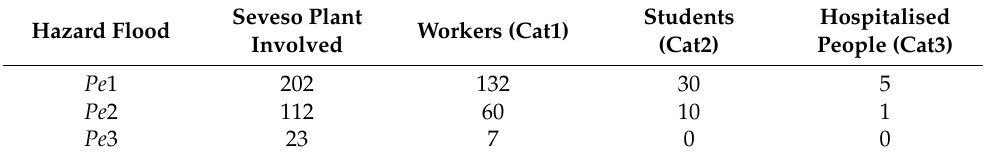
Table 3. Seveso establishments and presence of no-residents in the buffer areas. Hazard